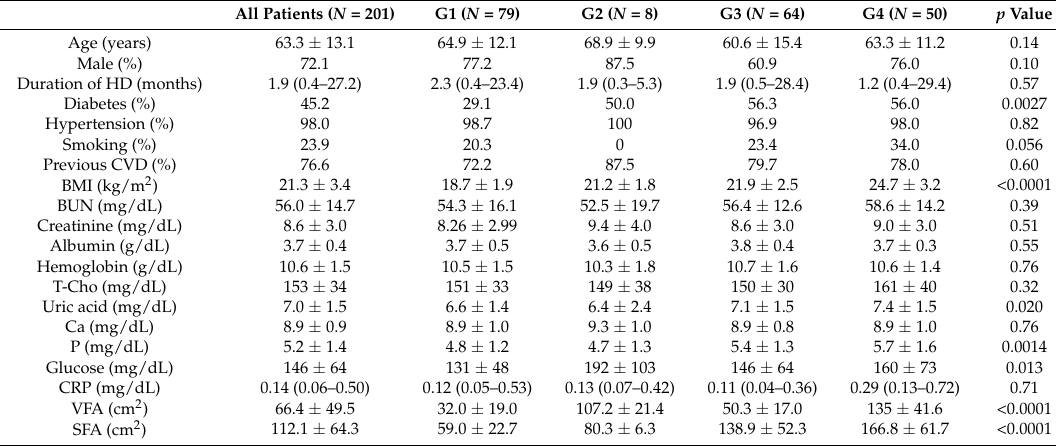
Table 1. Baseline patient characteristics.